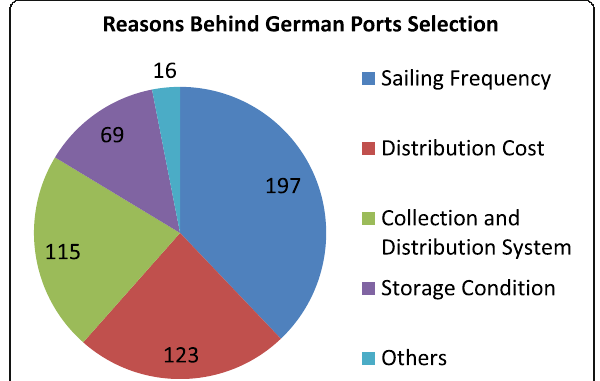
Fig. 3 Reasons behind german ports selection. (Source: Authors)